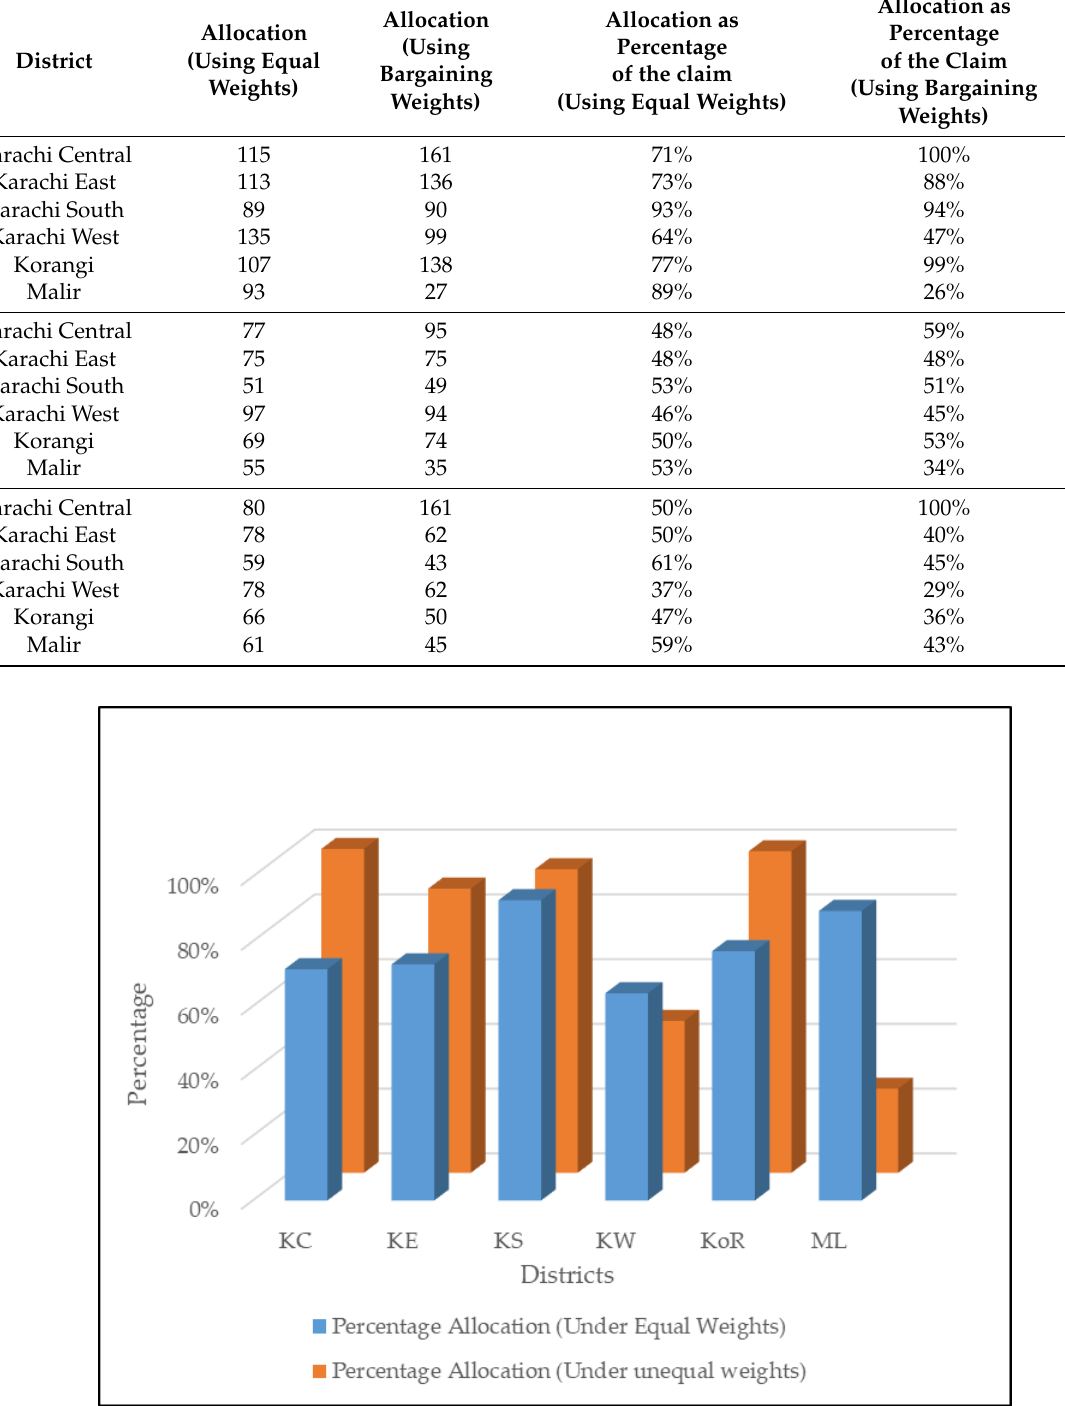
Figure 2. Water allocation under homogenous and heterogenous weights (scenario 1).